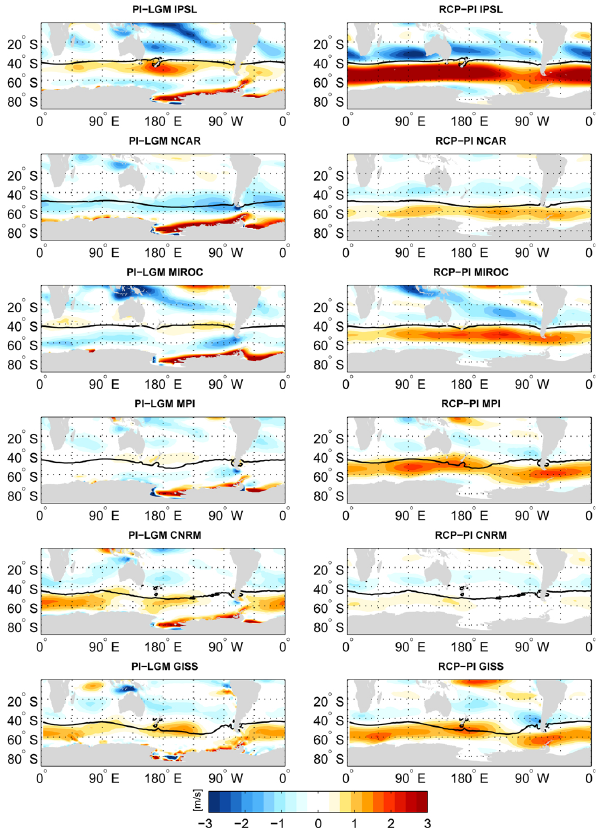
Fig. 2. Anomalies (in ms − 1 ) in 850-hPa mean annual zonal wind for the six models studied here. Left column: PI–LGM, right col- umn: RCP–PI. The position of the PI jet stream maximum is indi- cated as a black